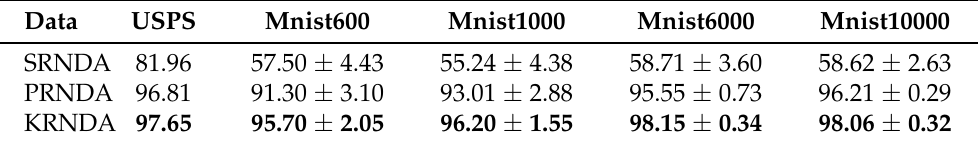
Table 3. The accuracy (%) comparison of different kernel method recognition